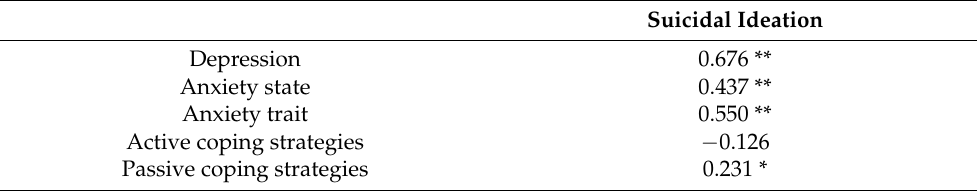
Table 2. Correlations between suicidal ideation and mental health and coping